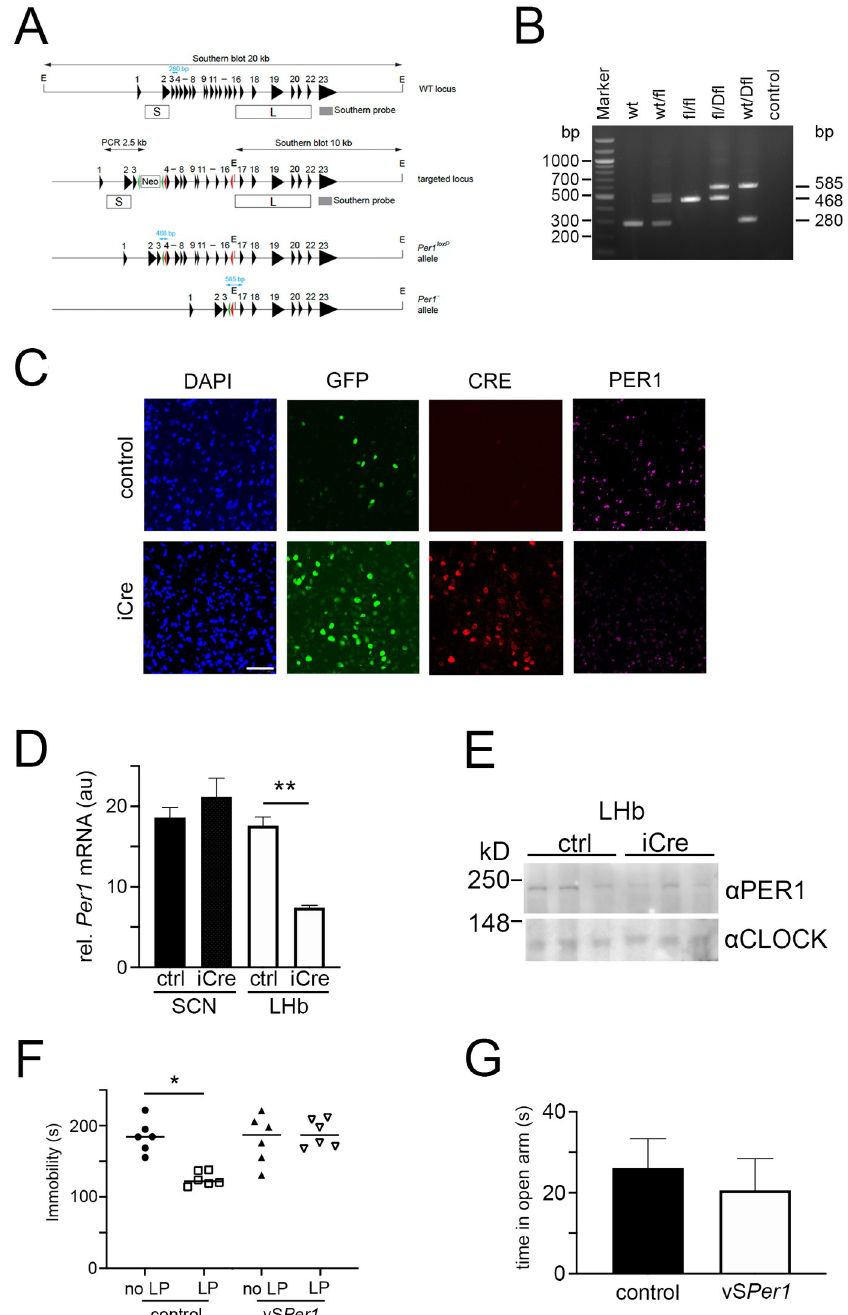
Fig 3. Deletion of neuronal Per1 in the area of the lateral habenula abolishes light effects on despair related behavior. (A) Scheme illustrating the generation of a conditional Per1 allele. For details see methods section. Numbers above black triangles indicate exons; E, EcoRI; neo, neomycin resistance; green triangles, FRT recombination sites; red triangles, loxP recombination sites; box S, short arm of homology; box L, long arm of homology; grey box, Southern probe; blue double arrows with numbers, PCR products representing the wild-type (wt), Per1 loxP (fl), and the Per1 - (Dfl) alleles. (B) 1.5% agarose gel visualizing the PCR products representing the wild-type (wt), Per1 loxP (fl), and the Per1 - (Dfl) alleles. (C) Immunohistochemistry visualizing PER1 (pink) in the LHb region of Per1 fl/fl mice after injection of a control AAV (top panels) or an AAV expressing CRE (red) (bottom panesl). Cell nuclei are visualized by DAPI staining (blue) and GFP (green) shows viral vector infected cells. Scale bar: 50 μ m. (D) Quantification of knock-down efficiency in the LHb compared to SCN. Per1 expression is significantly reduced by AVV Syn-iCre compared